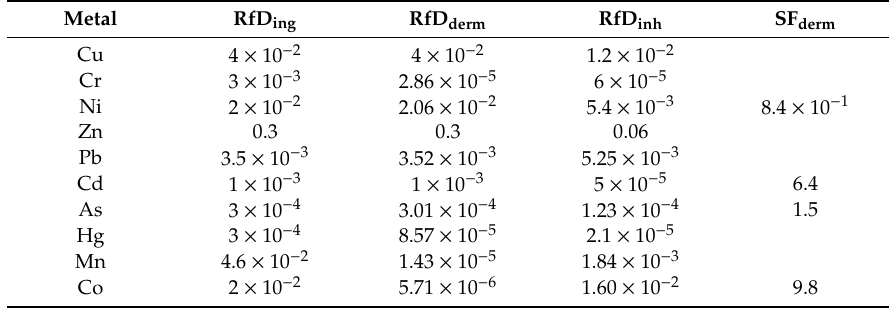
Table 2. Heavy metal risk reference slope factors (SFs) and reference doses (RfDs; mg / (kg · d)). Metal RfD